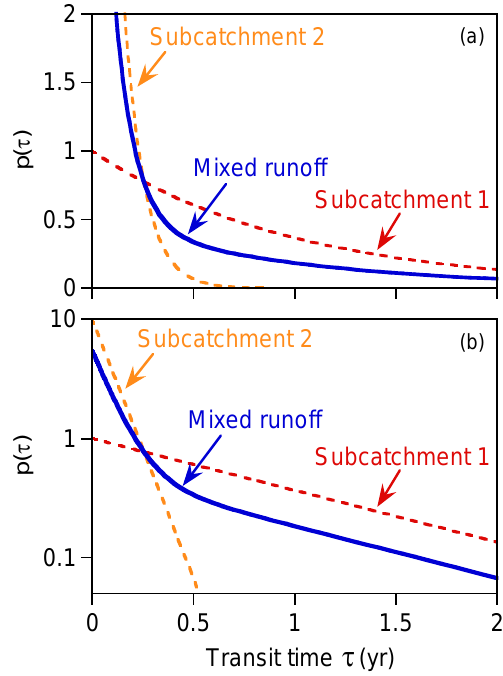
ments 1 and 2 in Fig. 4 (with mean transit times of 1 and 0.1 years, shown by the orange and red dashed lines, respectively), and the hy- perexponential distribution formed by merging them in equal pro- portions (solid blue line). (a) and (b) show linear and logarithmic